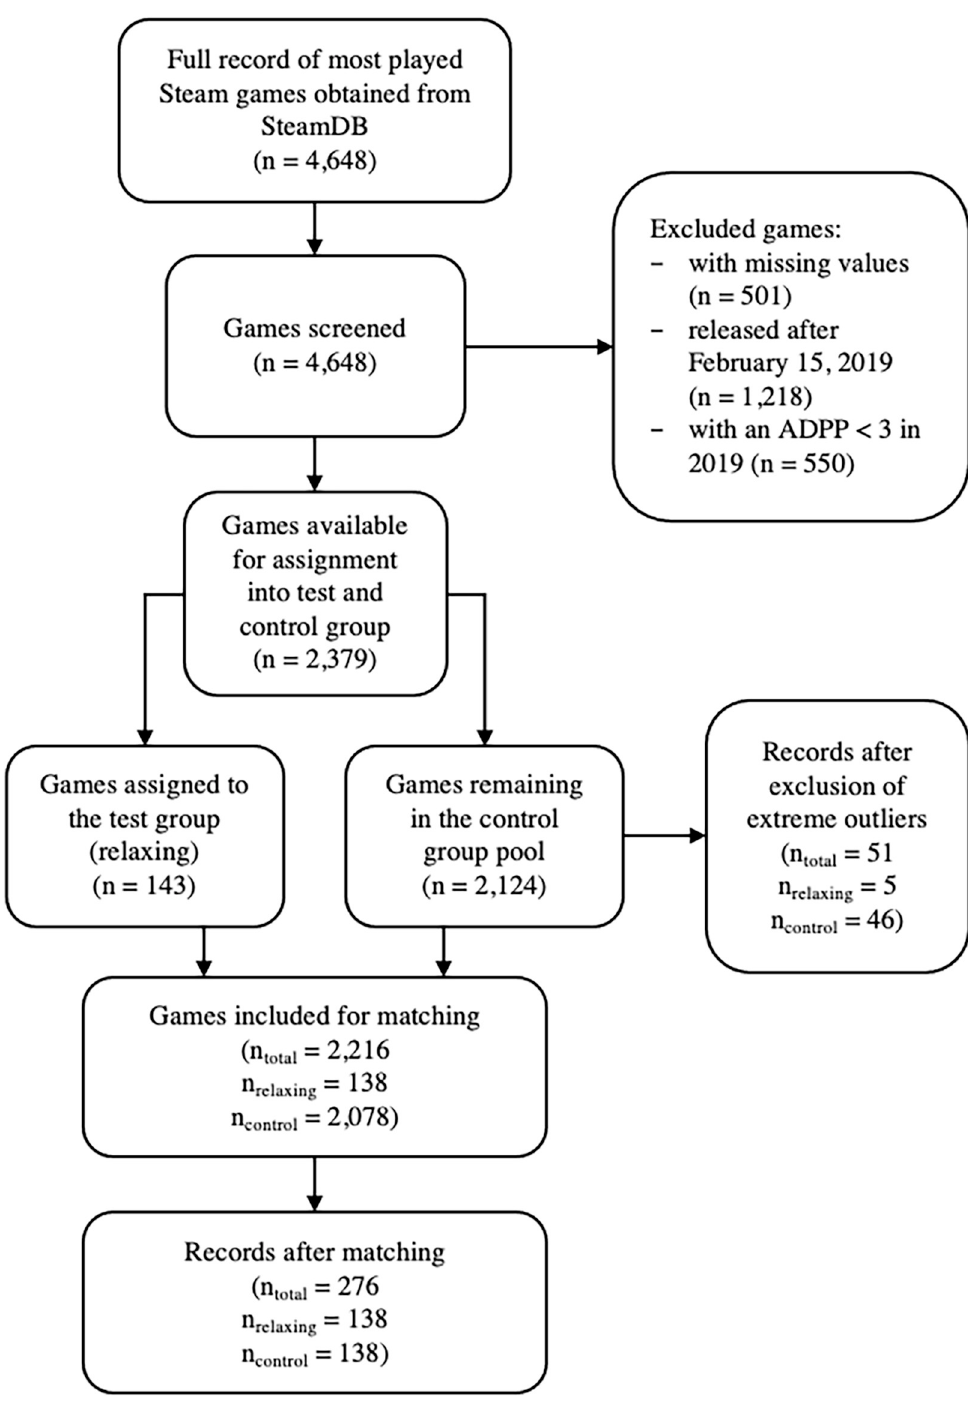
Fig 1. Flow diagram of the number of games screened and included in the study.